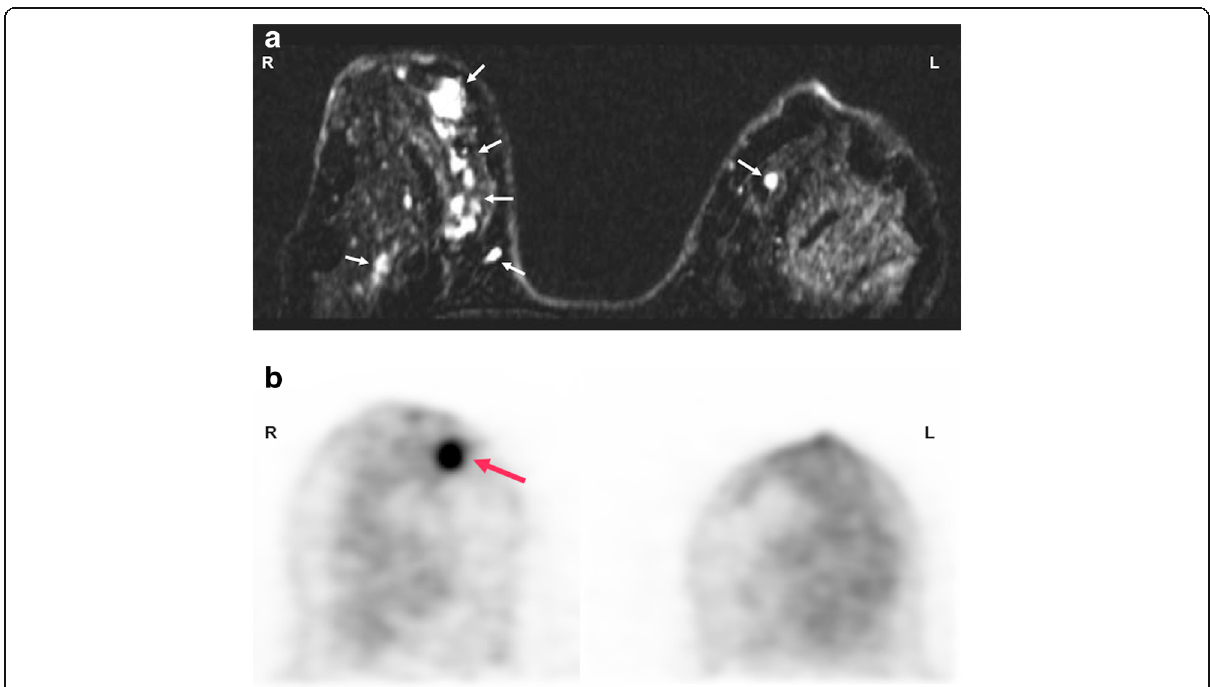
Fig. 14 A 48-year-old woman with breast cancer. a Axial contrast-enhanced T1-weighted MR image of breasts performed during last week of menstrual cycle showed bilateral multiple nodular areas of enhancement in both mammary glands (white and red arrows). b A dedicated FDG- PET exam only depicted a nodular mass (red arrow) with increased FDG uptake in the right breast, corresponding to a invasive ductal